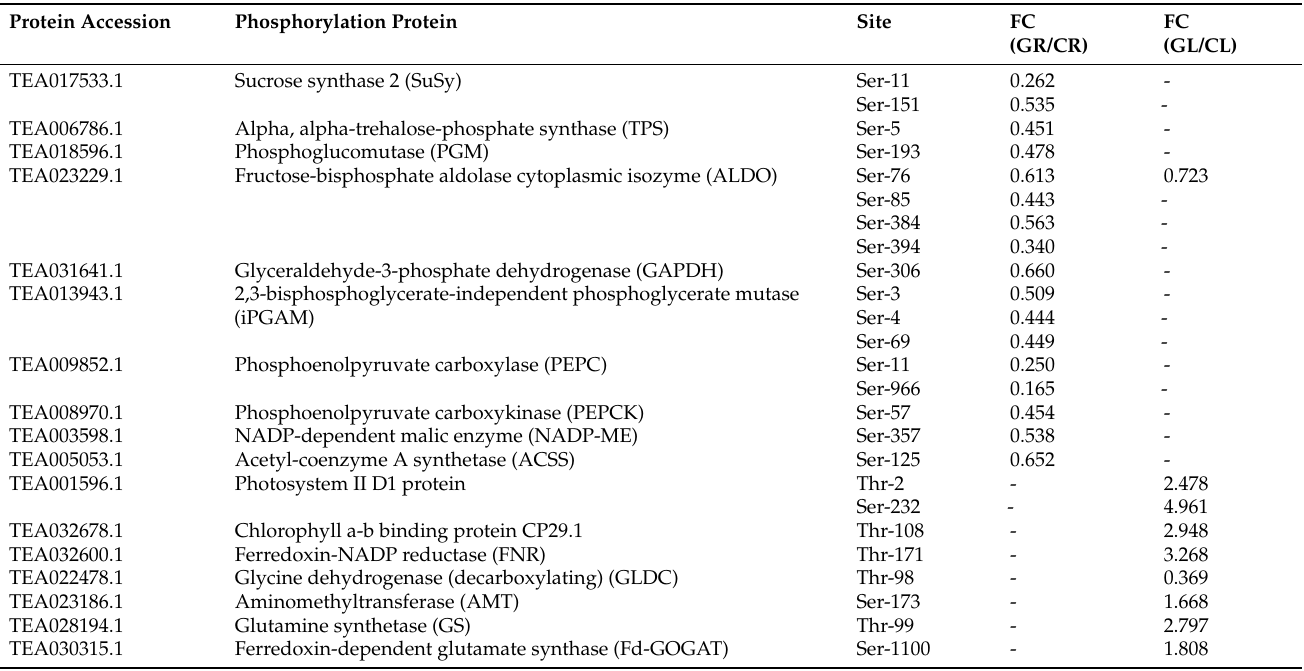
Table 4. Differential phosphorylation proteins and sites related to energy metabolism, amino acid metabolism, and